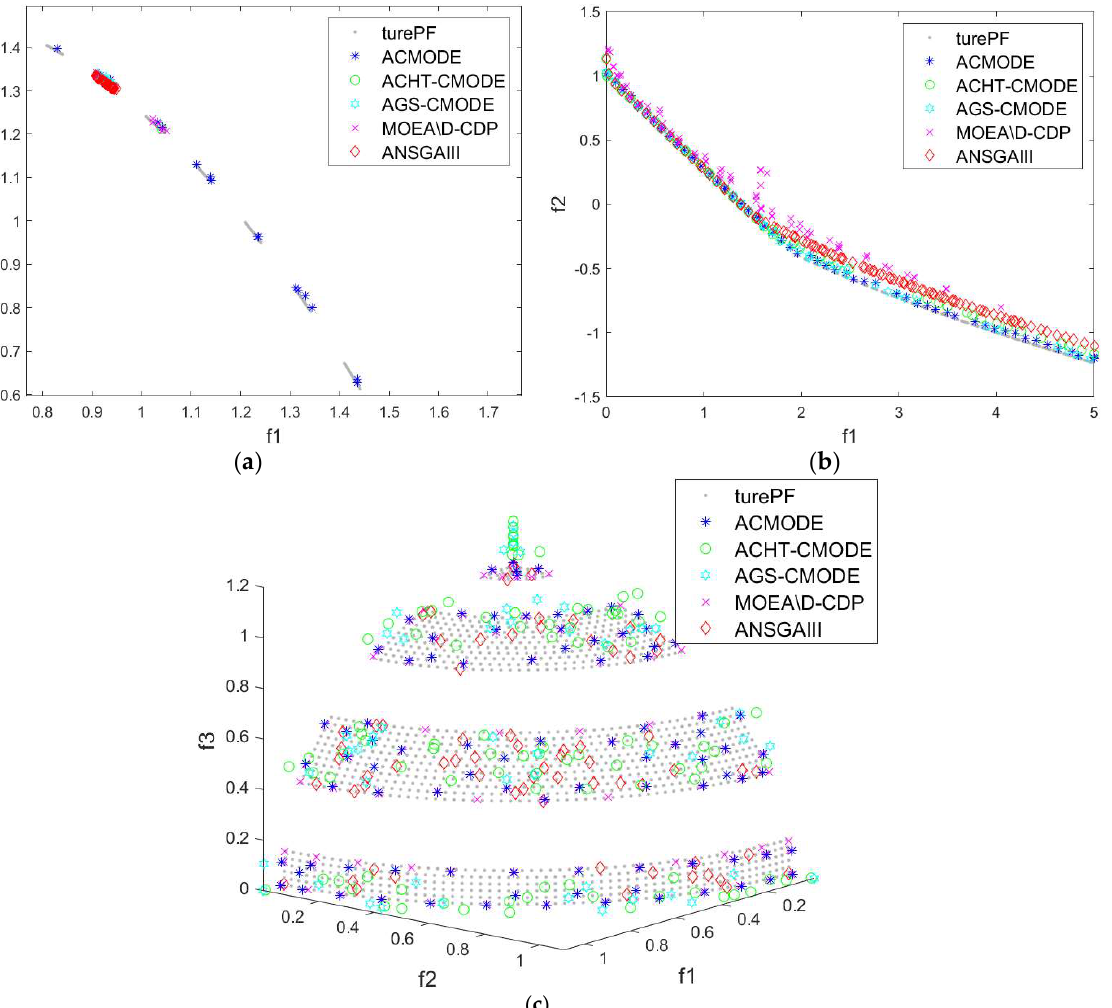
Figure 4. PF approximation of all compared algorithms. ( a ) LIR-CMOP3, ( b ) NCTP9, ( c ) MW8.